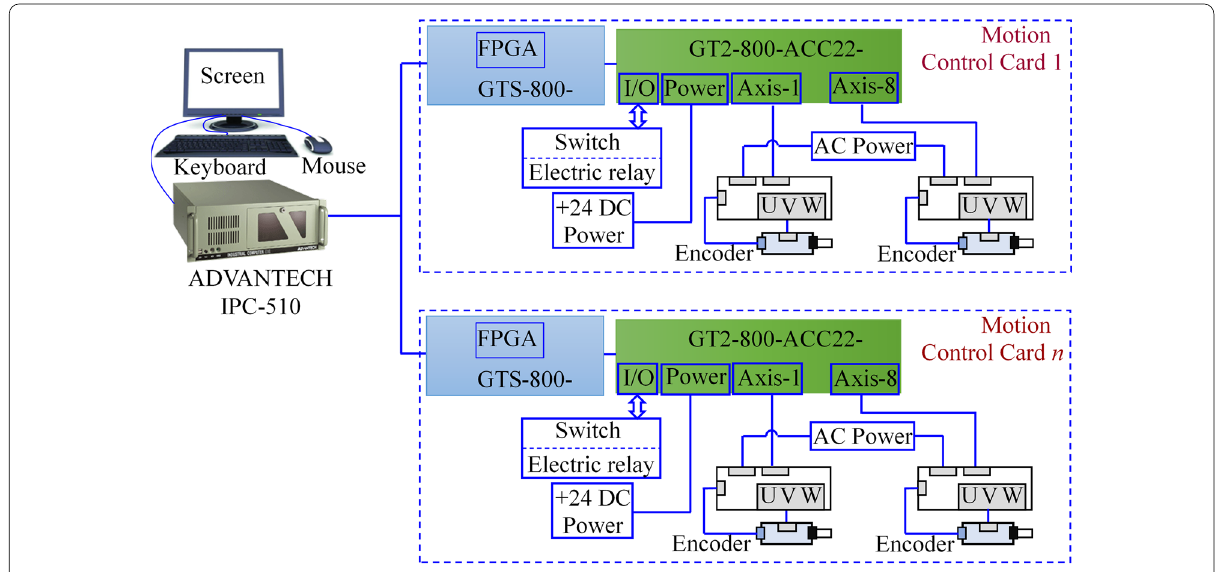
Figure 19 Hardware structure of the control system of HRETR